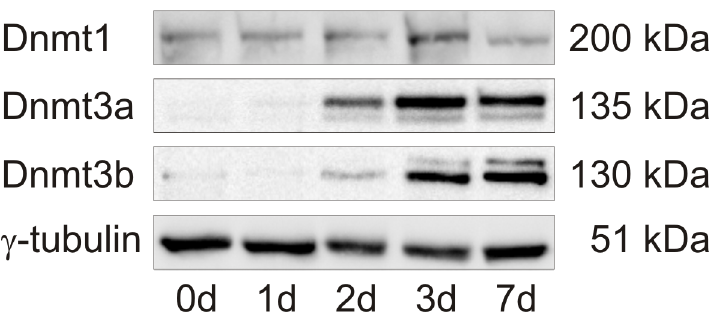
Fig 6. Western blot analysis of Dnmts during HSC activation. Exemplary results during a HSC time course experiment. Protein levels were determined in freshly isolated and 1, 2, 3 or 7 days cultured HSC. The analysis showed an overall increase of the de novo DNA methyltransferases Dnmt3a and Dnmt3b. Detection of γ -tubulin served as loading